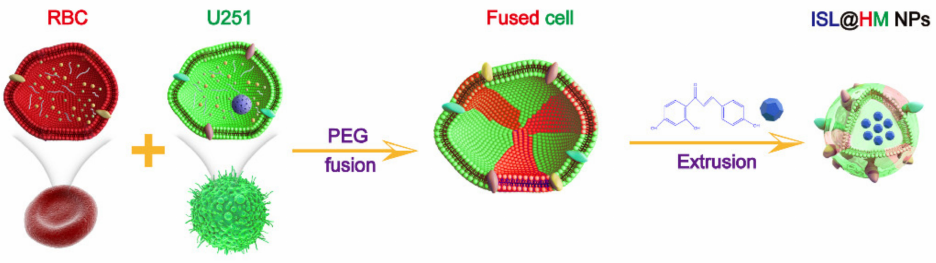
Figure 1. Illustration of the preparation of drug loaded ISL@HM